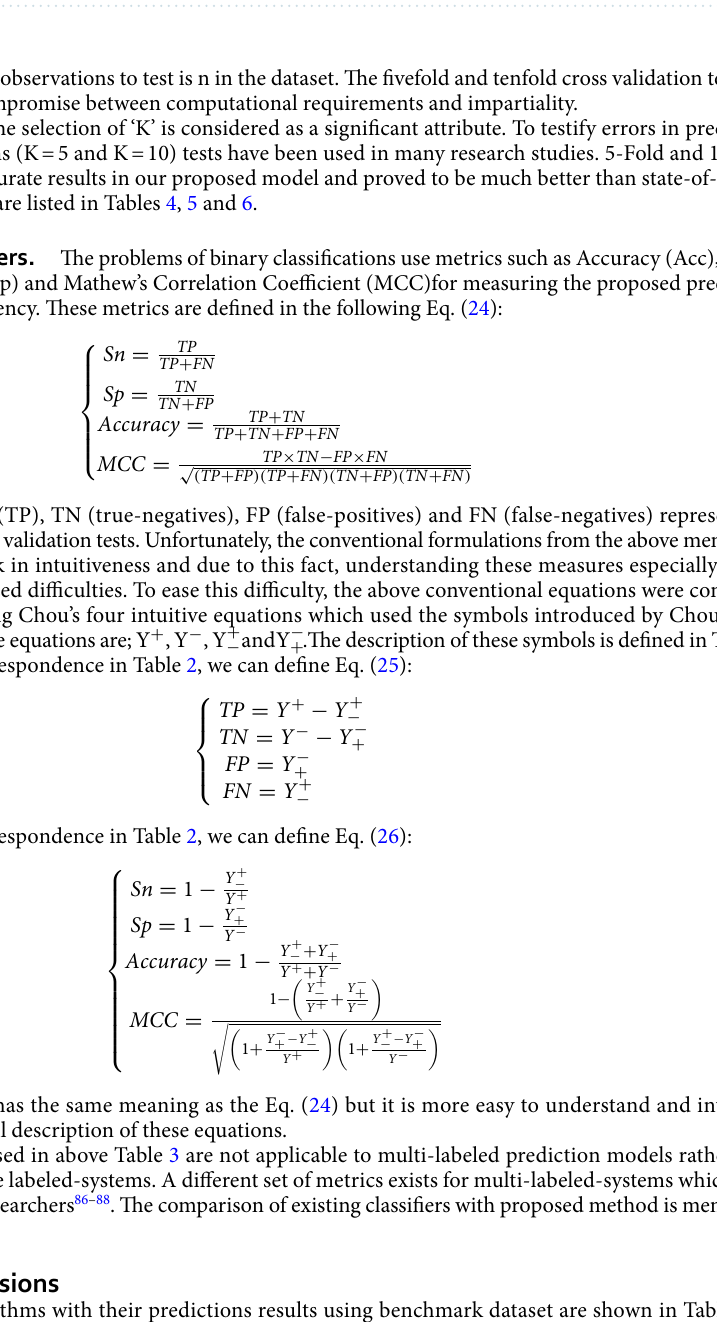
Table 2. Description of symbols used to define these